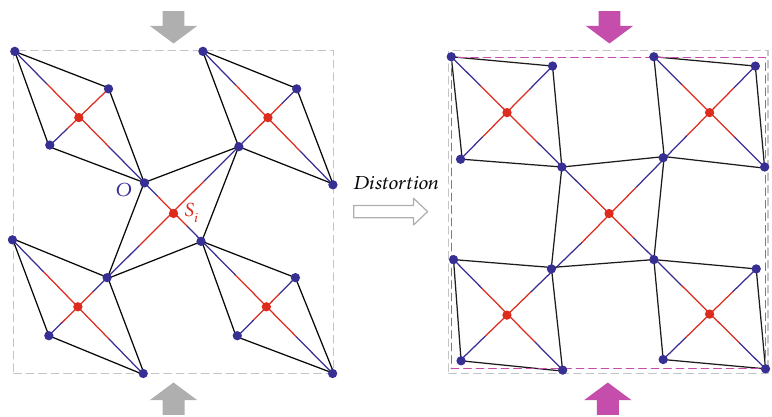
Figure 13: Rhombi structure model of S